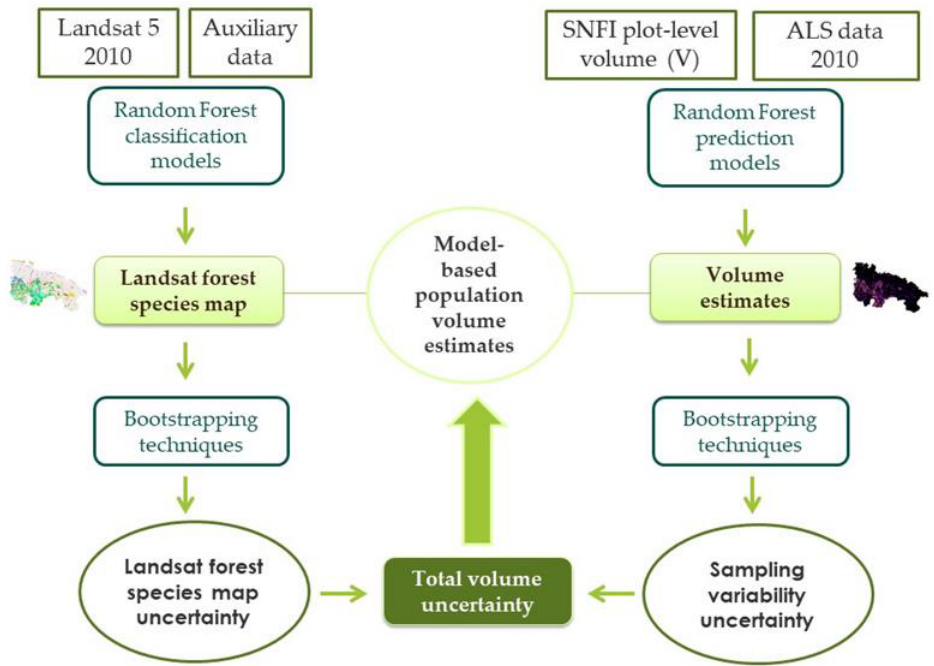
Figure 2. Workflow diagram of the processing steps conducted to account for the sources of uncertainty involved in the volume estimation.